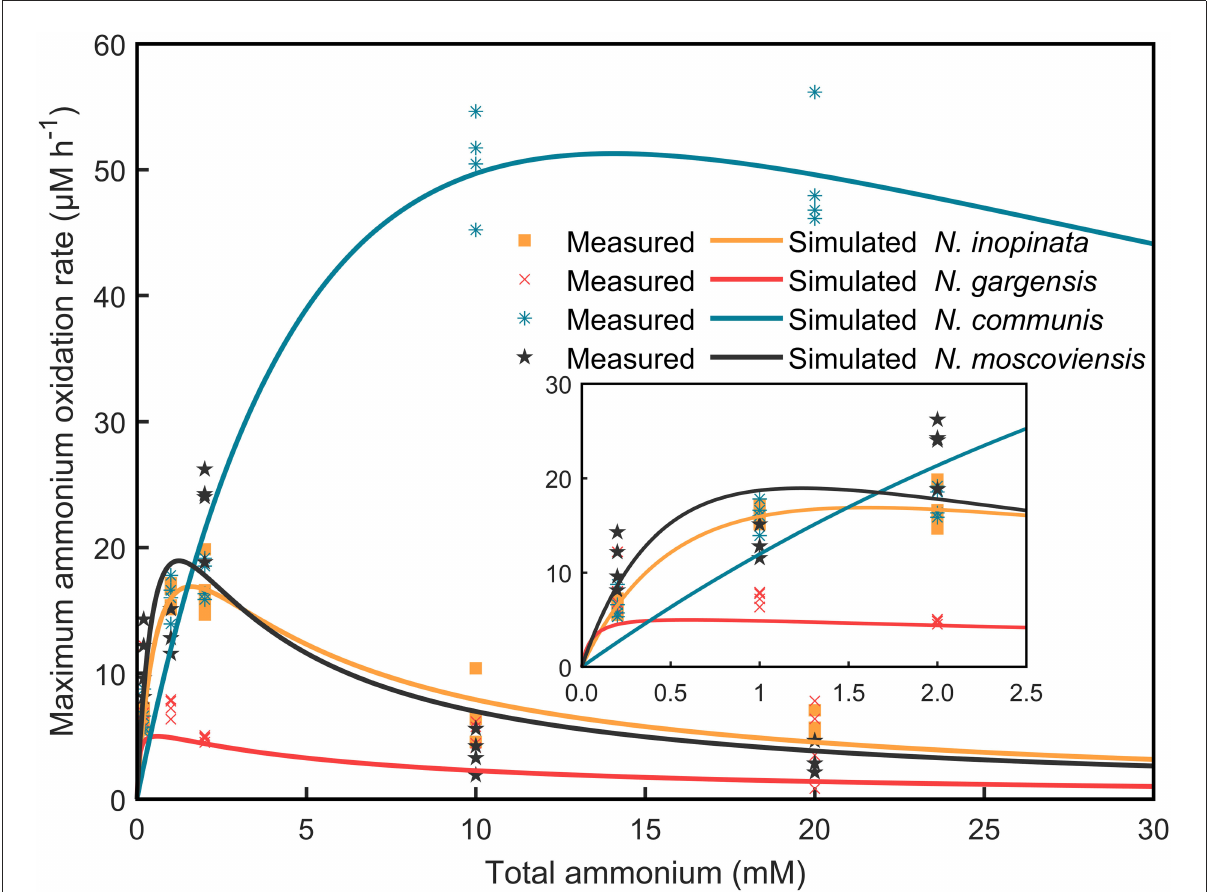
FIGURE4 Specific ammonium/nitrite oxidation rates of four nitrifiers were fitted by using the Haldane model. The consumption of ammonium/nitrite against time in N1, N2A, N2B, and N2C communities at 0.2, 1, 2, 10, and 20mM ammonium concentrations was extracted, and specific ammonium/nitrite oxidation rates were calculated and further fitted by using the Haldane model. The scatters mean the measured values with four replicates, while the solid lines show the fitted